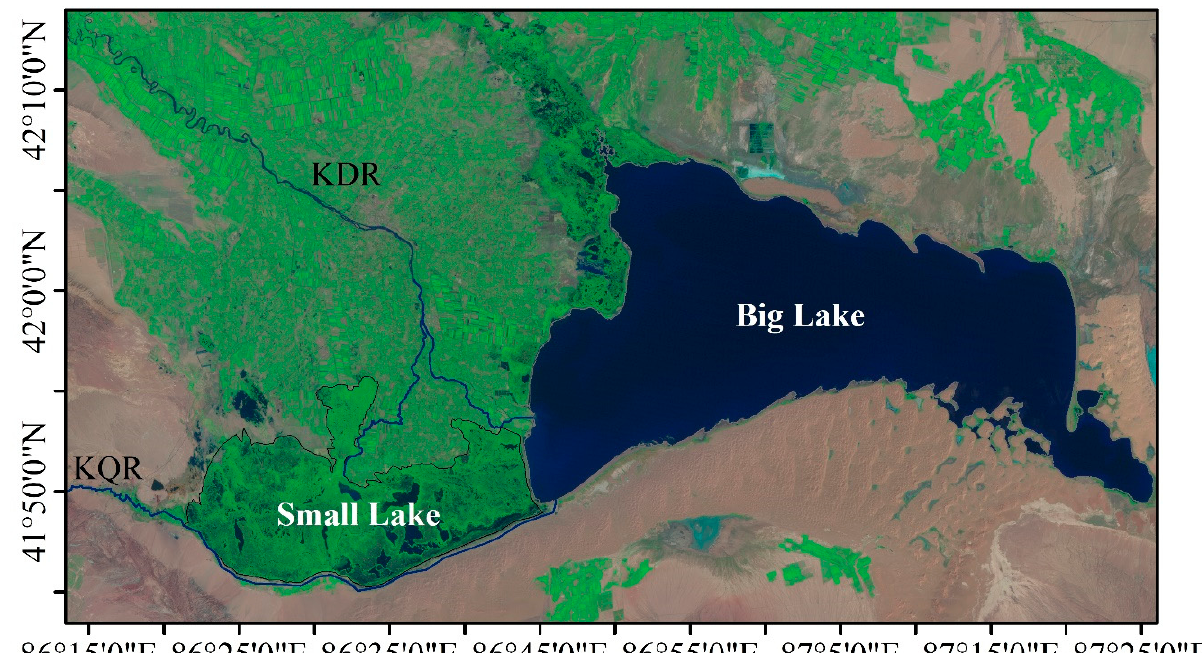
Figure 1. The schematic map of the Bosten Lake (Landsat bands 7, 4, and 2 pseudo-color composed image) showing its big lake and small lake (where KDR and KQR represent Kaidu River and Kongque River).